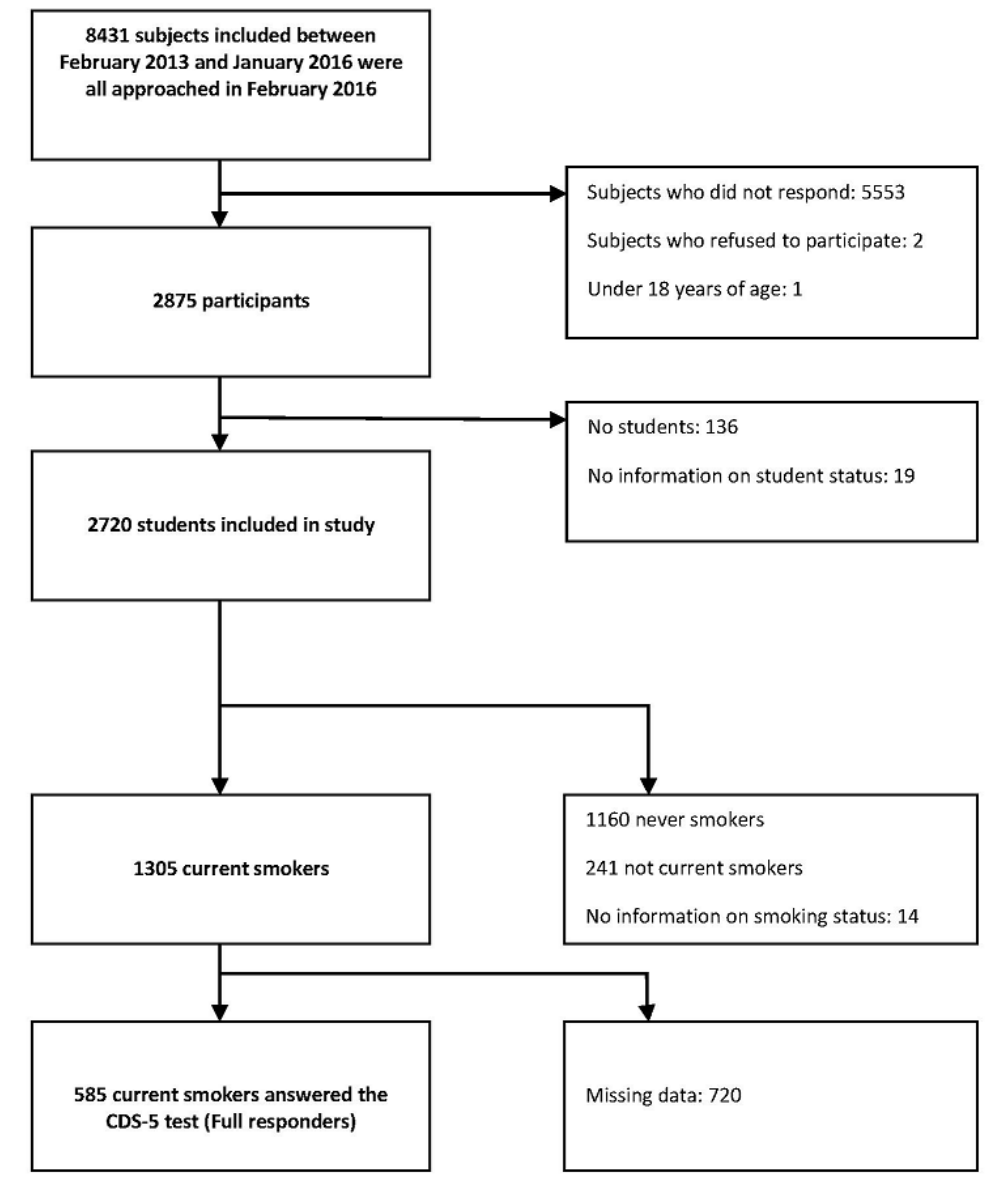
Figure 1. Flow chart. CDS-5: 5-item Cigarette Dependence